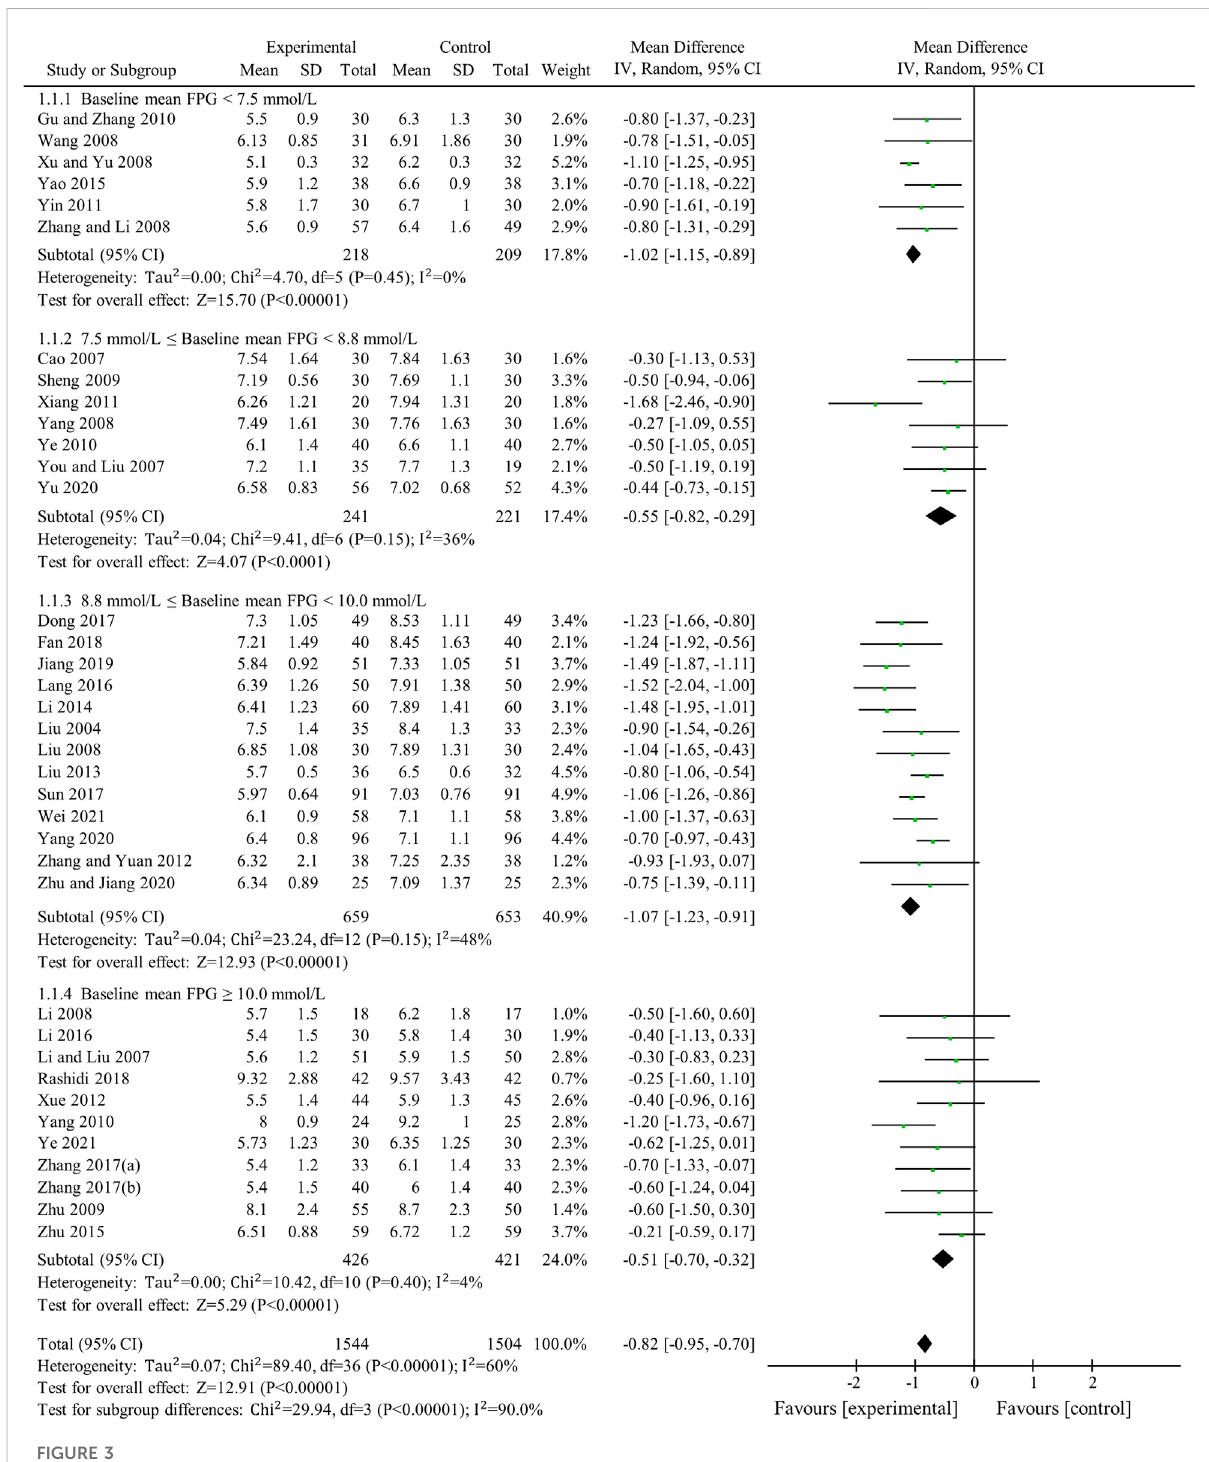
FIGURE 3 Meta-analysis of the effect of BBR on